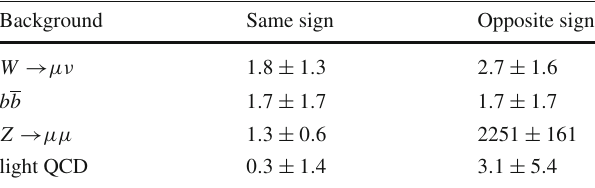
Table 3 Extrapolated background yields in the signal region for same- sign and opposite-sign muon channels. The uncertainty is statistical Background Same